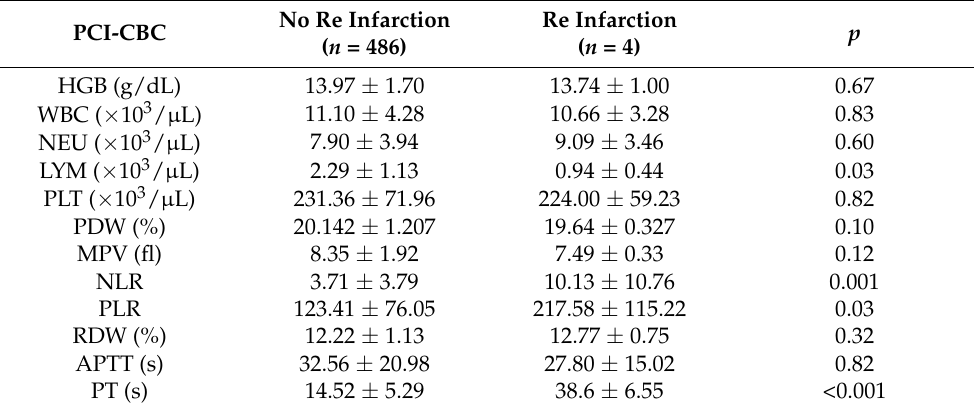
Table 15. Hematological and coagulation parameters of the groups with/without re infarction in ACS patients treated with